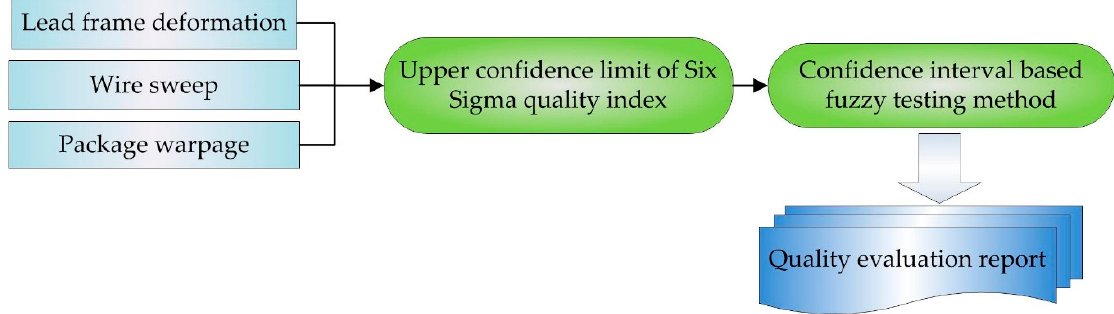
Figure 2. Flowchart of the fuzzy evaluation model for the IC packaging molding process.